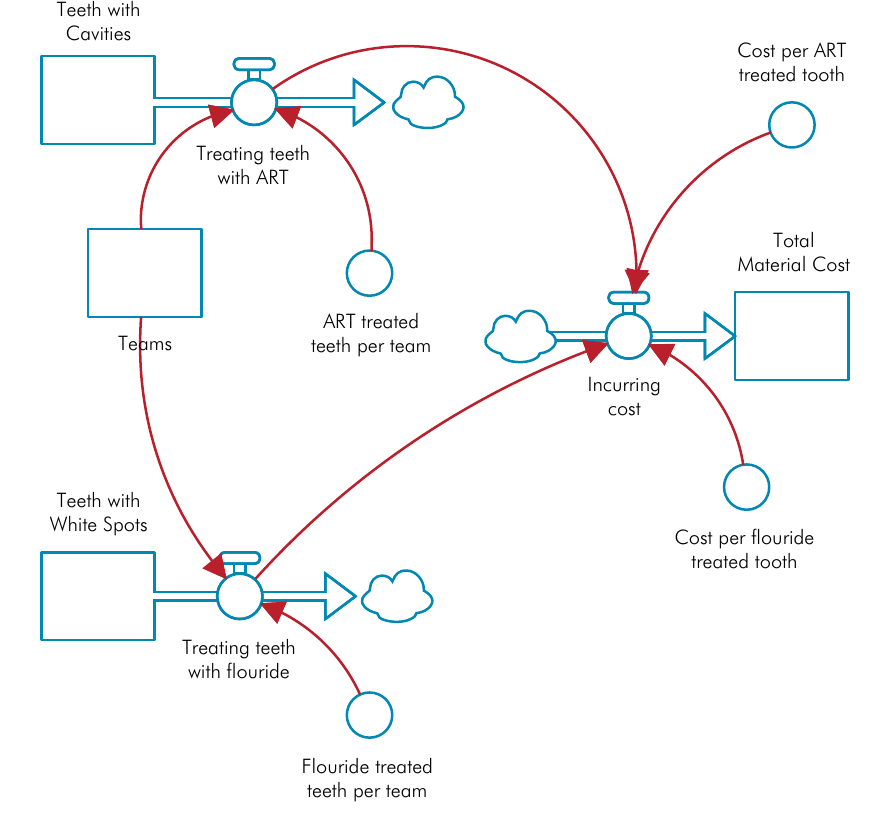
Figure 2. System Dynamics Model to estimate the cost and clinical hours required to control dental caries in preschoolers conducted by a local oral health team.